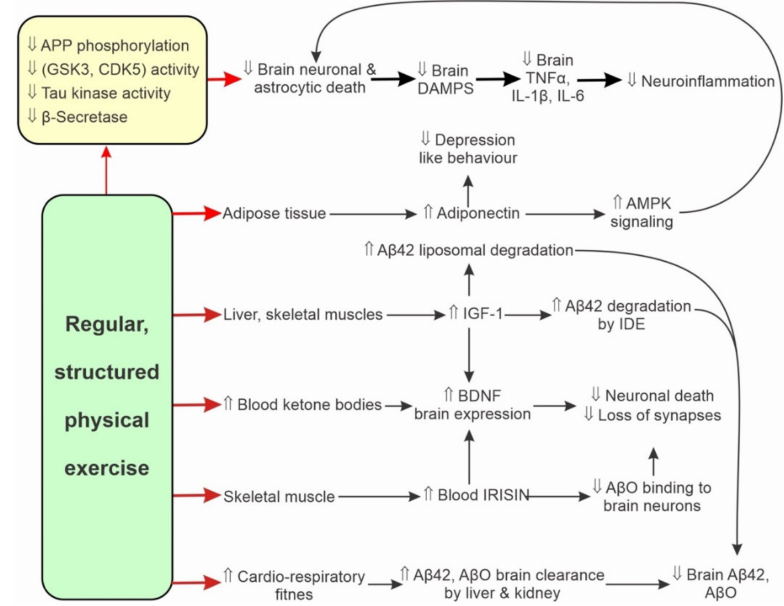
Figure 2. Modulation of neuroinflammation and A β peptides processing by regular, structured physical exercise. Abbreviations: A β 42 (amyloid β peptide with 42 amino acid residues), A β O (toxic amyloid β oligomers), AMPK (5 (cid:48) AMP-activated protein kinase), DAMPS (damage-associated molecular patterns), BDNF (brain-derived neurotrophic factor), CDK5 (cyclin dependent kinase 5), DAMPS (damage asso- ciated molecular patterns), GSK3 glycogen synthase kinase 3), IDE (insulin-degrading enzyme), IGF1 (insulin-like growth factor 1), IL -1 β , -6, (interleukins -1 β , -6), TNF α (tumour necrosis factor α